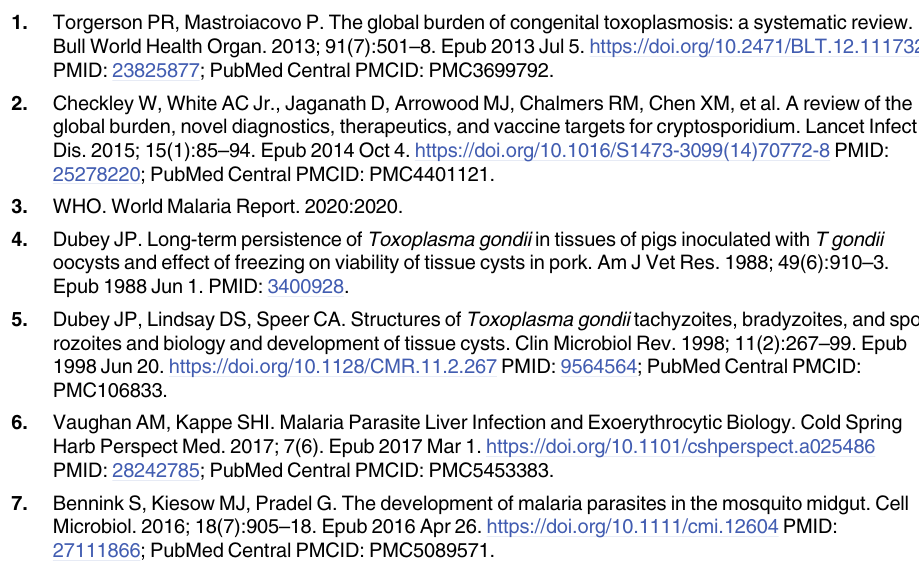
S1 Table. Orthologs of acyl-CoA synthetases and AcAS identified for phylogenetic analy- sis. The full amino acid sequences of Pf ACS9, Pf ACS10, Pf ACS11, and Pf AcAS, and the partial amino acid sequence of Pf ACS12 (the first 664 amino acids, excluding the thiamin-diphos- phate-binding fold domain) were used as query sequence (green) in an iterative search (jackhmmer) (5 iterations) for orthologs in the UniProtKB database [160]. E-values found in our jackhmmr search are reported, and hits were identified as genes that showed an E-value of < 10 − 50 for at least 1 query sequence. The E-value of genes that were below the E-value cutoff for a query sequence are indicated in red. The following genes were excluded from phyloge- netic analysis: genes that were not identified as hits as the E-value was below the cutoff for all query sequences (gray shading), genes that did not align using the partial deletion cutoff of 50% in our alignment using ClustalW (dark gray shading), and genes that did not cluster with other genes in the phylogenetic tree (blue